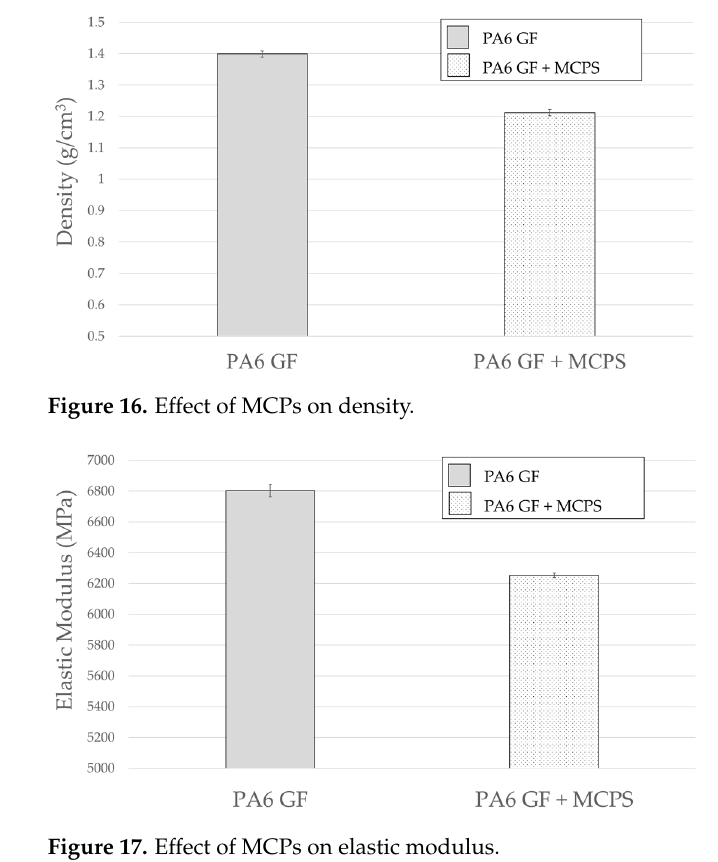
Figure 15. Effect of MCPs on damping ratio of the roof-rack specimen.